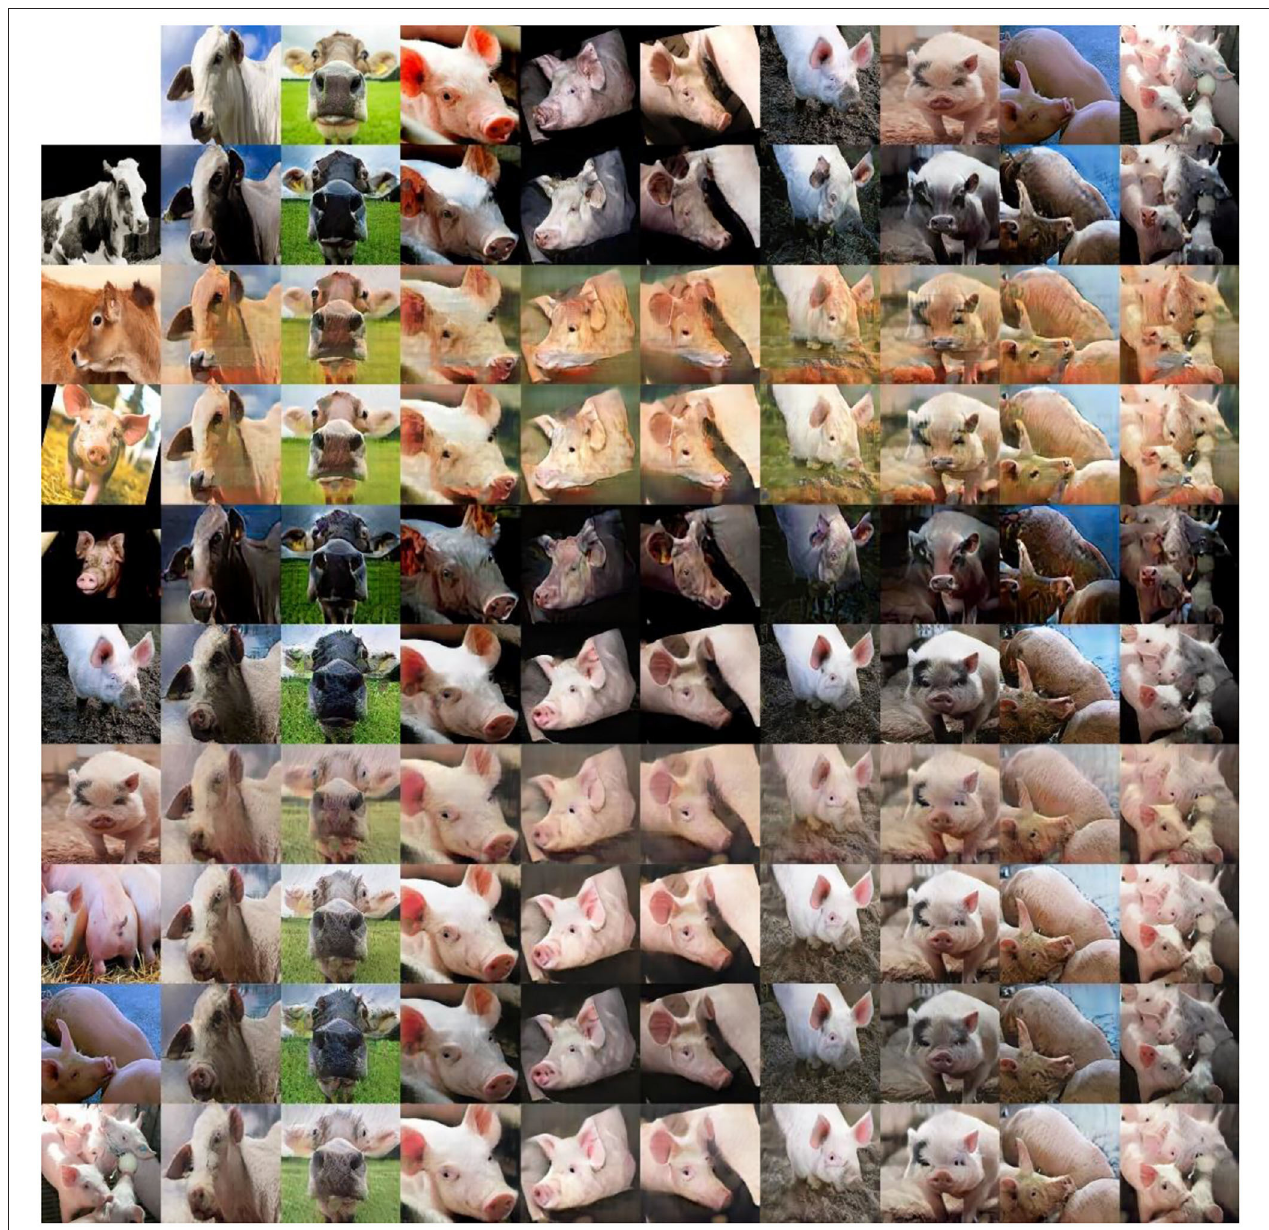
FIGURE 2 | Example application of Generative Adversarial Networks (GAN) in livestock farming. Images of faces of farm animals such as cows and pigs generated by several epochs by the StarGAN architecture-based model. Quantitative comparison of the cow/pig dataset trained model is represented in each row. The real-life cow and pig are depicted in the top first row and the left first column. The StarGAN translated the source images of cows and pigs into target domains, reflecting the styles of the reference images as a precursor for the development of digital avatar of farm animals